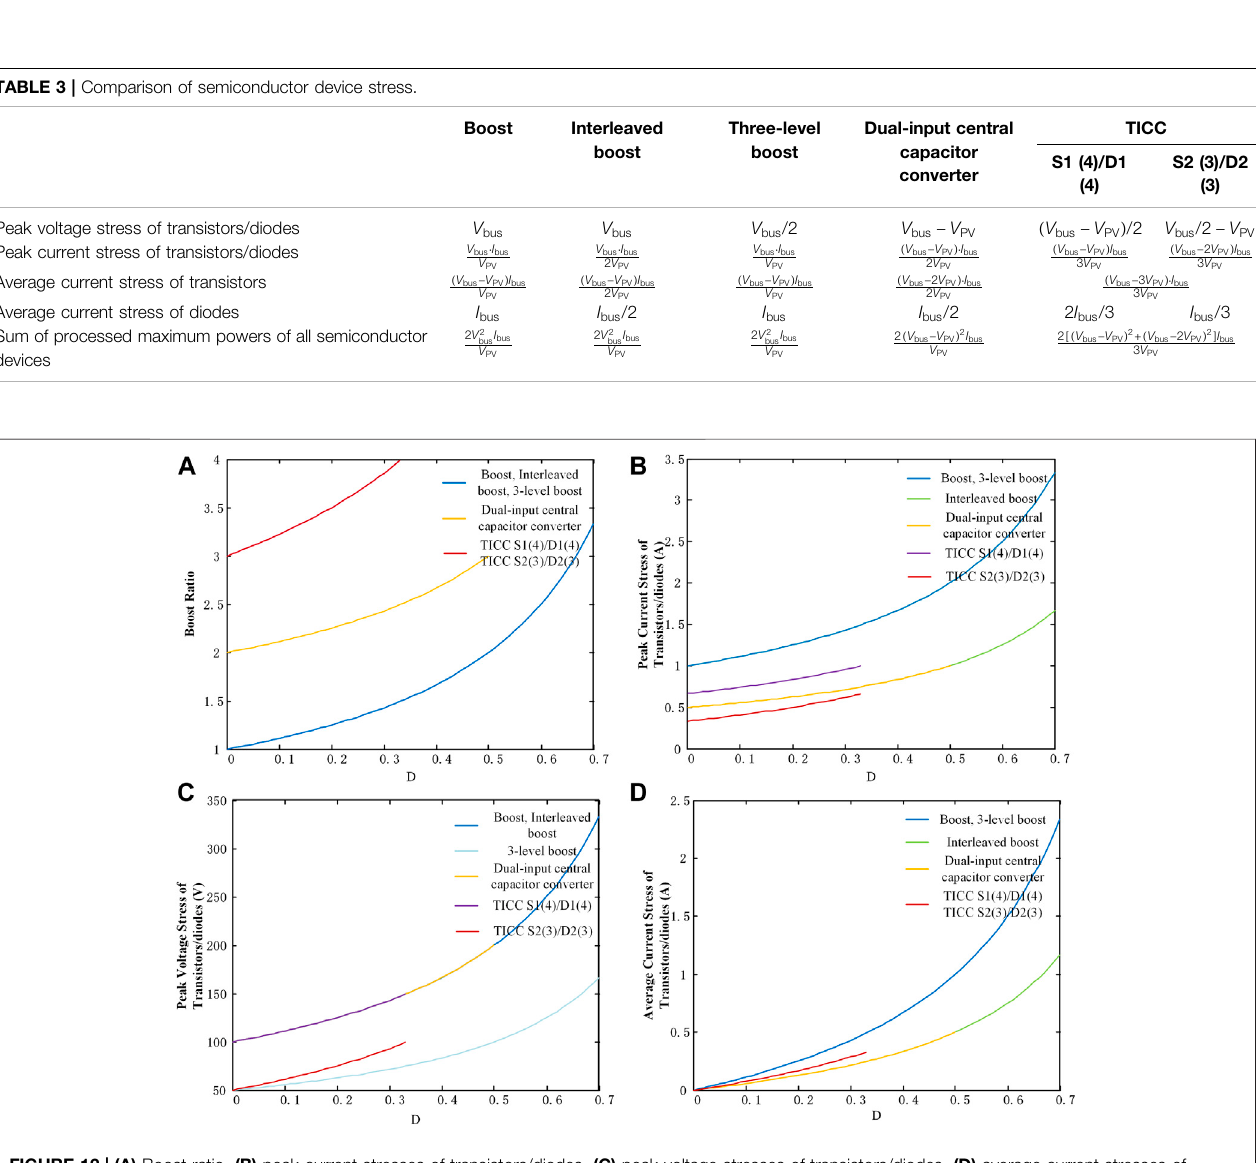
Frontiers in Energy Research |